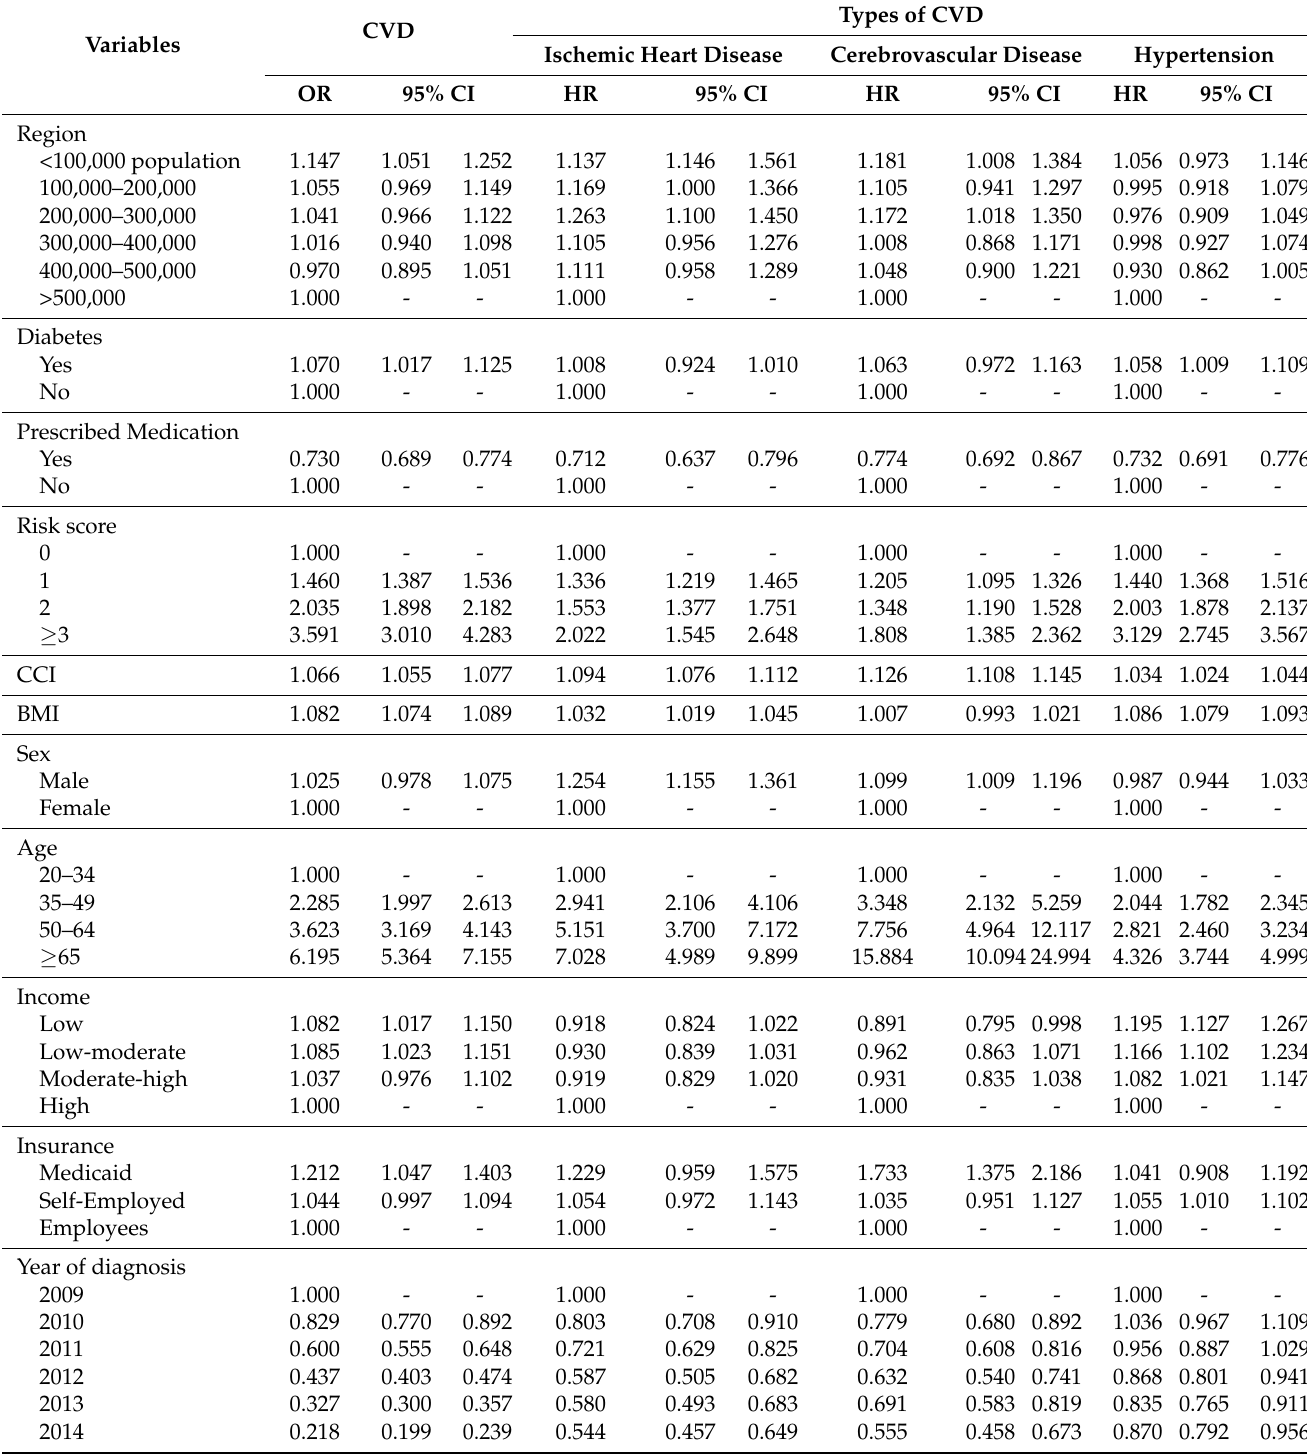
Table 2. Regional association between CVD